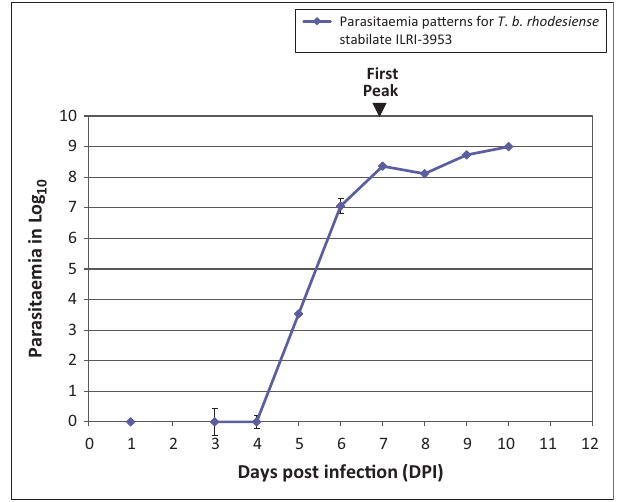
4.87. 10 FIGURE 2: Mean parasitaemia pattern for T. b. rhodesiense ILRI-3953 infection in Swiss white mice. The first peak occurred at seven DPI. Mean parasitaemia at the first peak was estimated at Log 8.36. All mice were found dead in their 10 cages or were euthanised by 10 DPI.